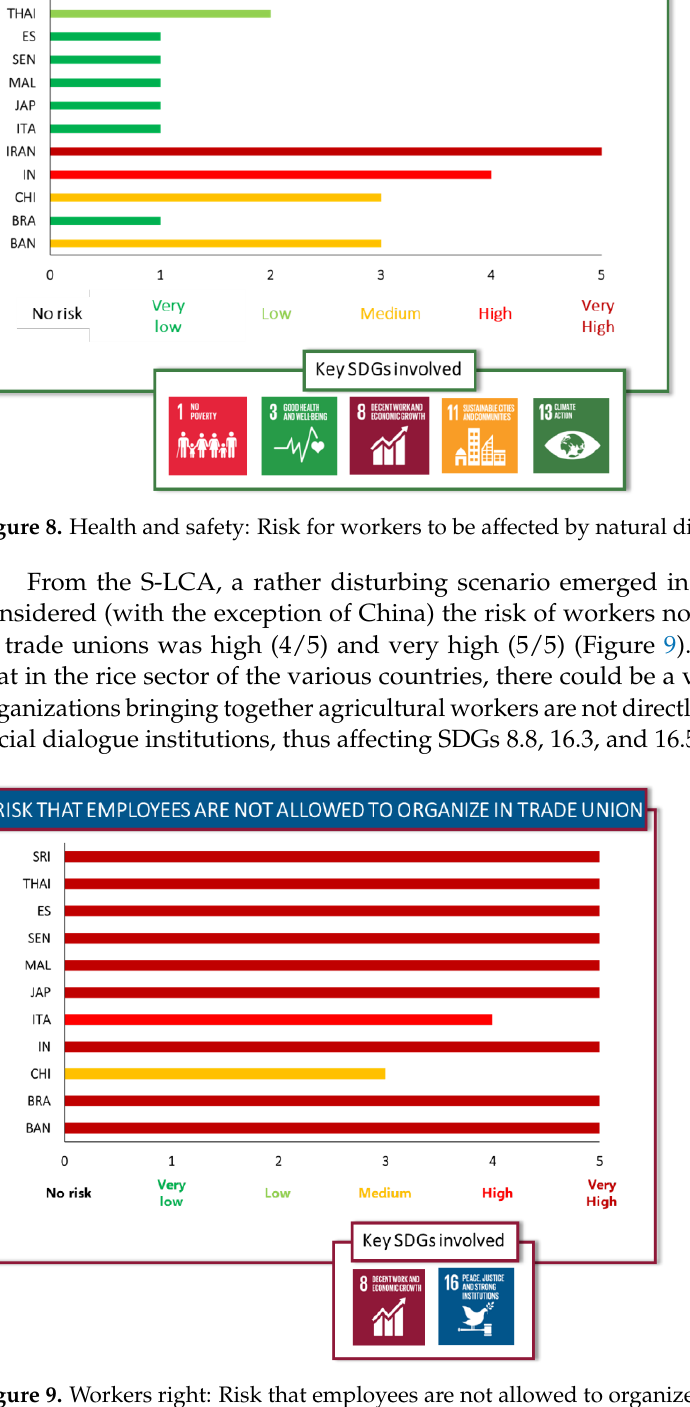
Figure 9. Workers right: Risk that employees are not allowed to organize in trade unions [69].